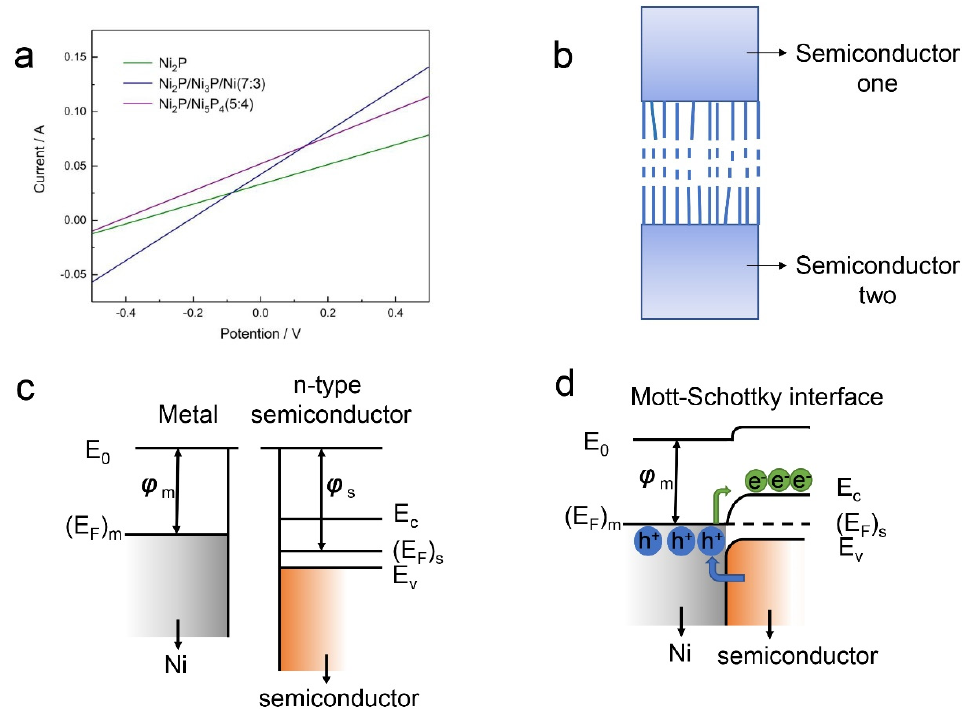
Figure 10. Linear sweep volt–ampere curve, schematic diagram of heterogeneous interface dangling bonds (unpaired electronics) generation, energy band diagrams of metal and semiconductors. ( a ) The Linear sweep volt–ampere curve of Ni 2 P/Ni 3 P/Ni (Ni/P = 7:3), Ni 2 P/Ni 5 P 4 (Ni/P = 5:4), and single phase Ni 2 P. ( b ) The schematic diagram of dangling bonds of heterogeneous interface. ( c , d ) The energy band diagrams of metal and semiconductors.